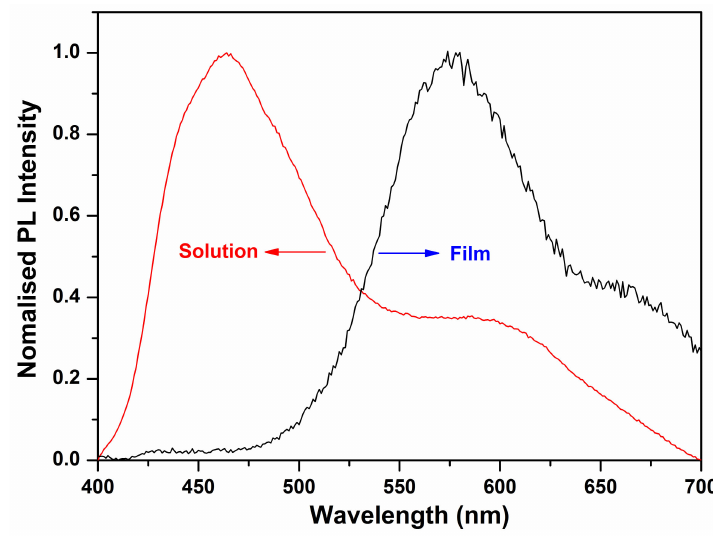
Figure 5. PL spectra of the oligomer BDT(DBTOTTH) 2 .